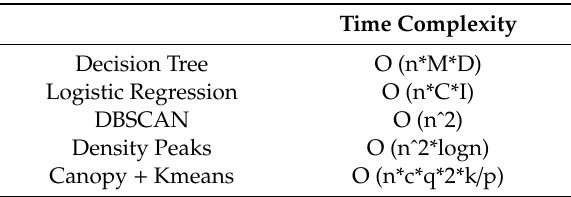
Table 7. Algorithm complexity comparison.